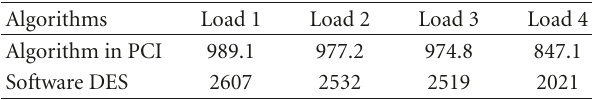
Table 1: Throughputs of SAME with di ff erent CPU loads (mea- sured in